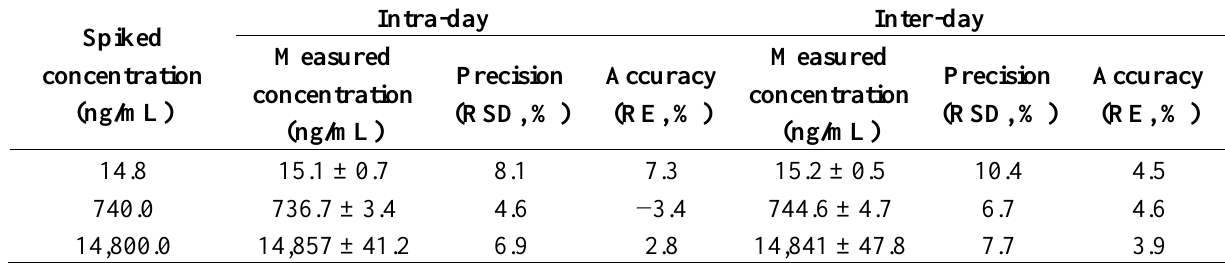
Table 3. Precision and accuracy for the analysis of QGR in rat’s plasma ( n = 5 days, six replicates per